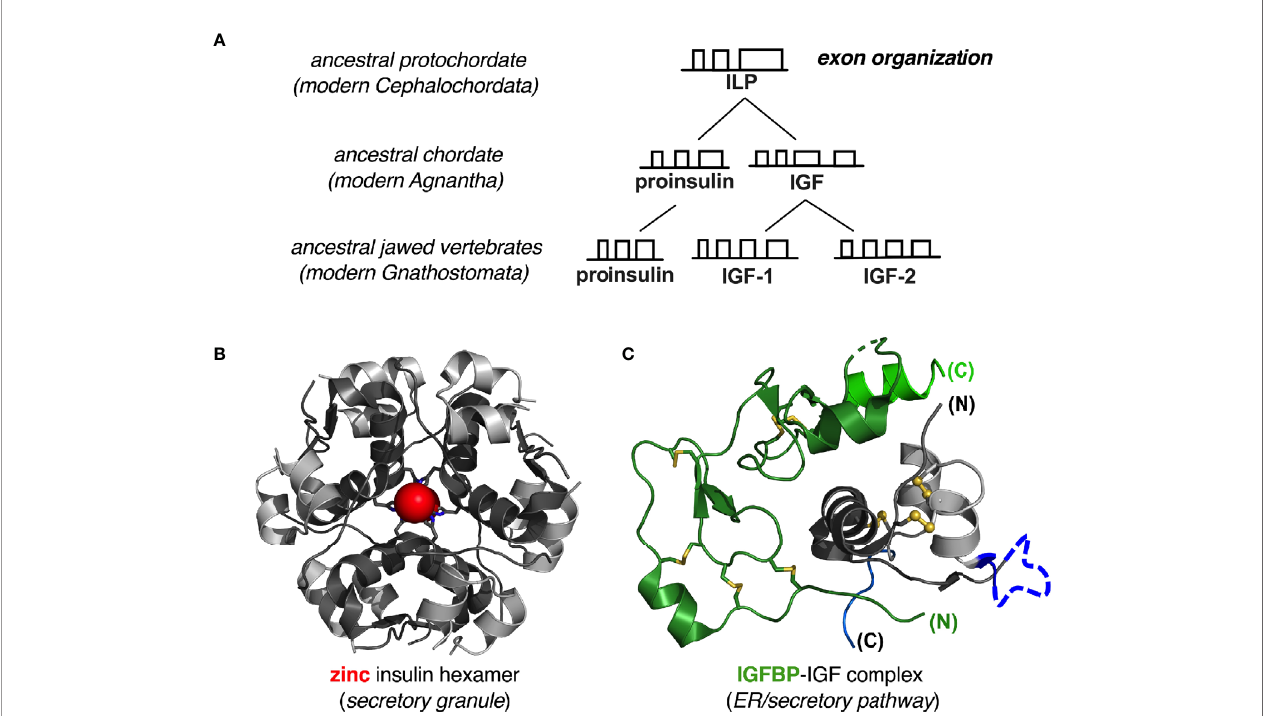
FIGURE 9 | Evolution of insulin-like genes in vertebrates. (A) Steiner and colleagues proposed that a primordial insulin-like gene in protochordates was the common ancestor of vertebrate insulin/IGF factors (215, 217). Amphioxus ILP represents this ancestral gene (as a “ living fossil ” ) prior to gene duplication in early agnathan vertebrates. Further gene duplication results in distinct IGF-I and IGF-II genes found in all gnathosomes (jawed vertebrates). Independent gene duplication events occurred during the evolution of invertebrate insulin-like peptides (not shown). See Supplemental Figure S1A for further details of exonic structure. (B) Proinsulin folds autonomously, and the mature hormone is stabilized by native self-assembly: ribbon model of classical zinc-insulin hexamer. The A- and B chains are shown in light- and dark gray, respectively; the two overlying axial zinc ions are shown as red spheres (enlarged for emphasis at twice Van der Waals radii), each coordinated by three His B10 side chains (sticks). (C) IGF-I and IGF-II fold together with speci fi c IGF binding proteins: ribbon model of illustrative IGFBP-IGF complex. We hypothesize that heterodimeric folding “ rescues ” the foldability of the IGFs, whose folding properties would otherwise be ambiguous. Color codes as follows: IGF domain A (light gray), domain B (dark gray), domain C (dark blue) and domain D (light blue); IGFBP N-terminal domain (dark green) and C- terminal domain (light green). Molecular coordinates were respectively obtained from PDB entries 1MSO (zinc insulin hexamer) (186) and 2DSP (IGF-1/IGFBP-4 complex)